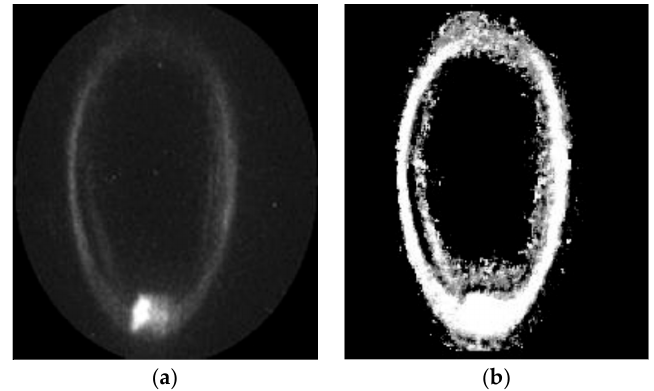
Figure 6. Auroral oval image and the corresponding deep feature map. ( a ) Auroral oval image. ( b ) The corresponding deep feature map.